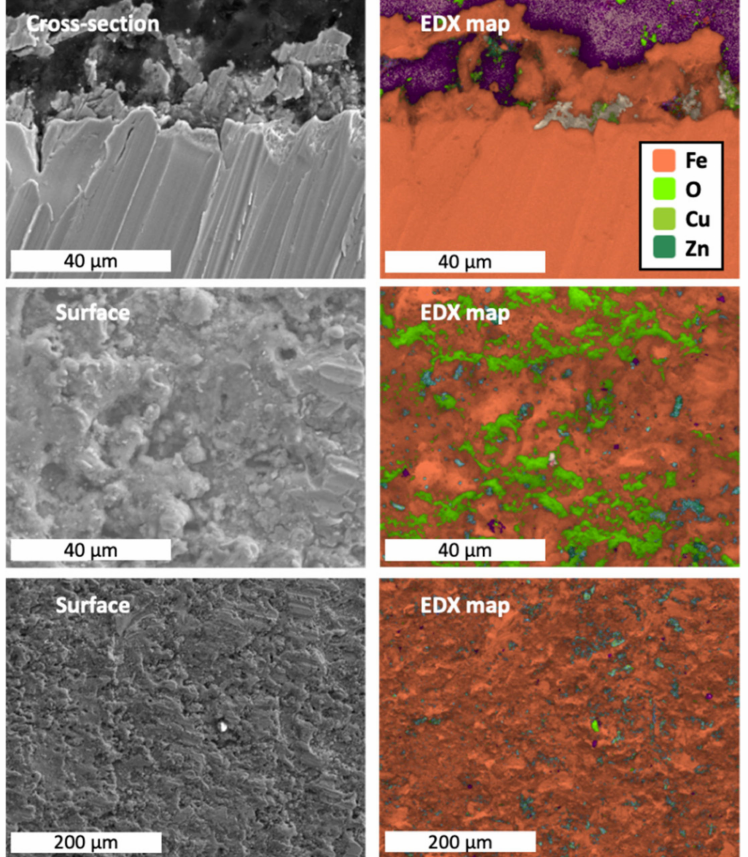
Figure 25. ( Left column ) SEM images (cross-section and surface) of a EUROFER97 sample, machined by wire-cut EDM; ( right column ) EDX maps of the cross-section and surfaces. The contamination by the brass-wire (Cu and Zn) is clearly